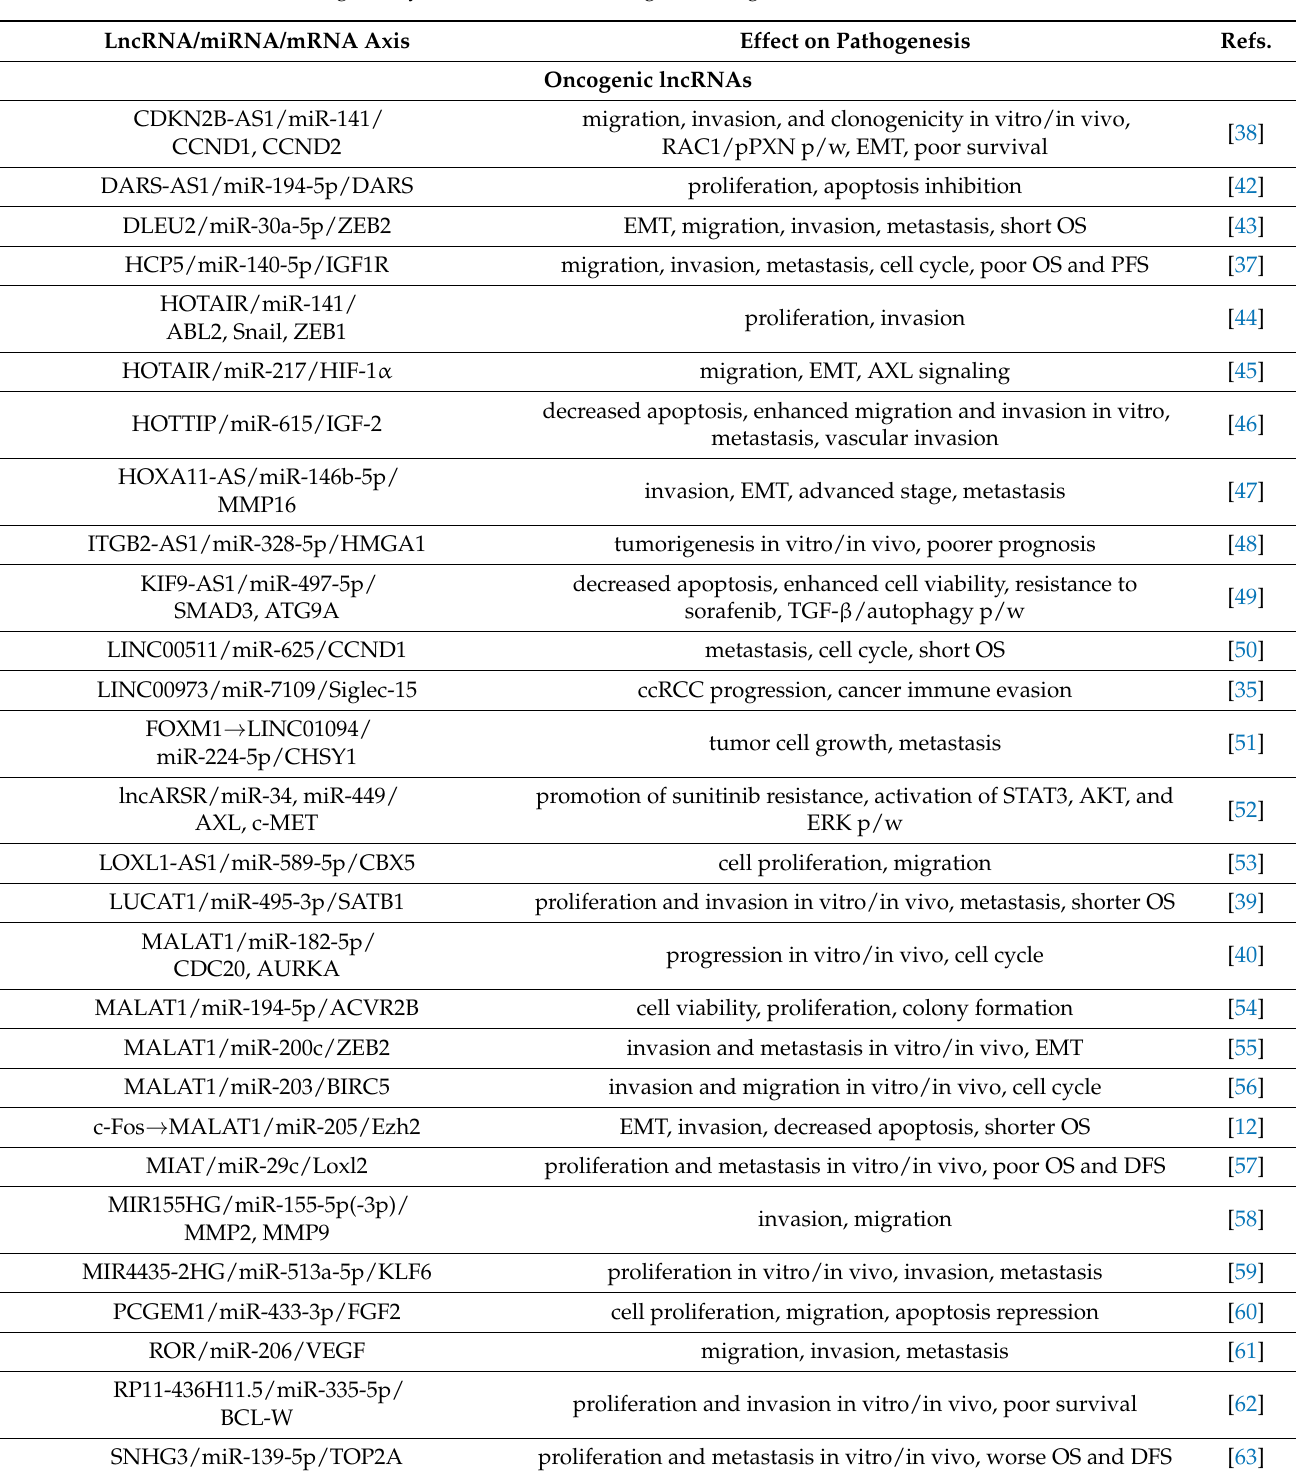
Table 1. Regulatory axes of lncRNAs acting according to the ceRNA model in